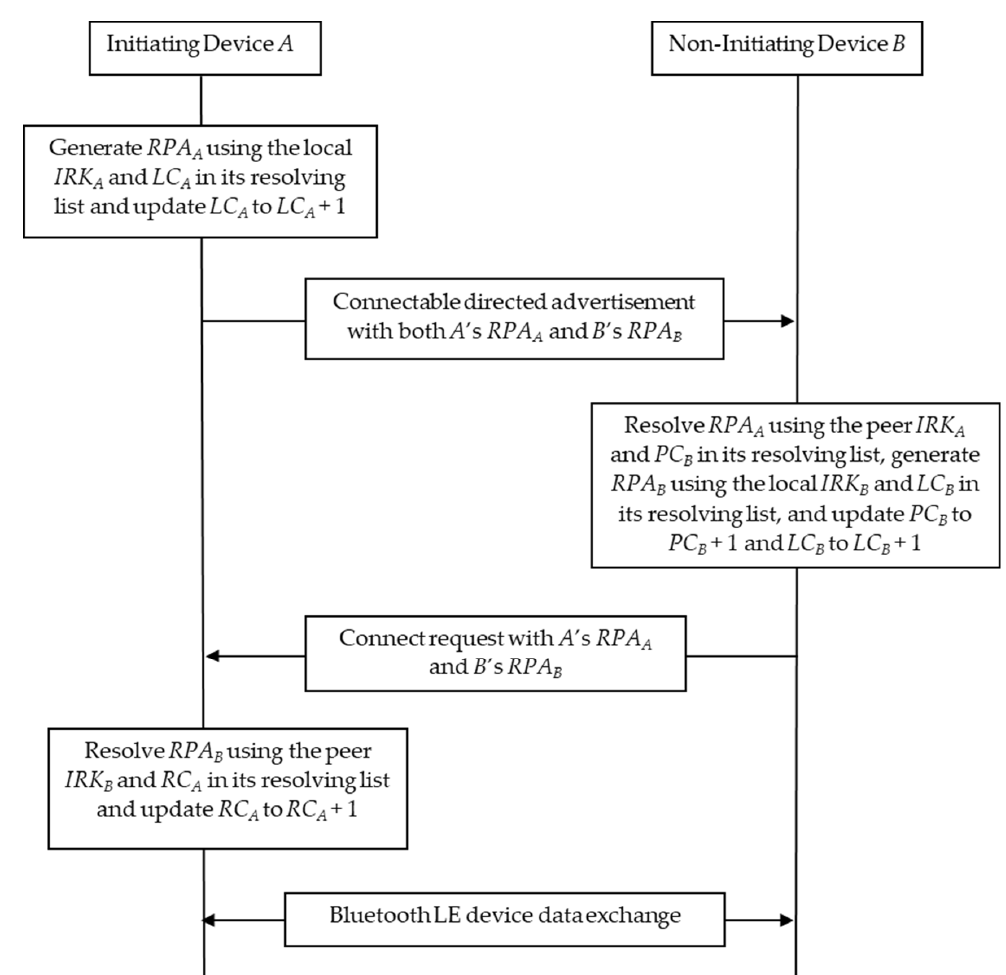
Figure 10. Improved reconnection procedure using